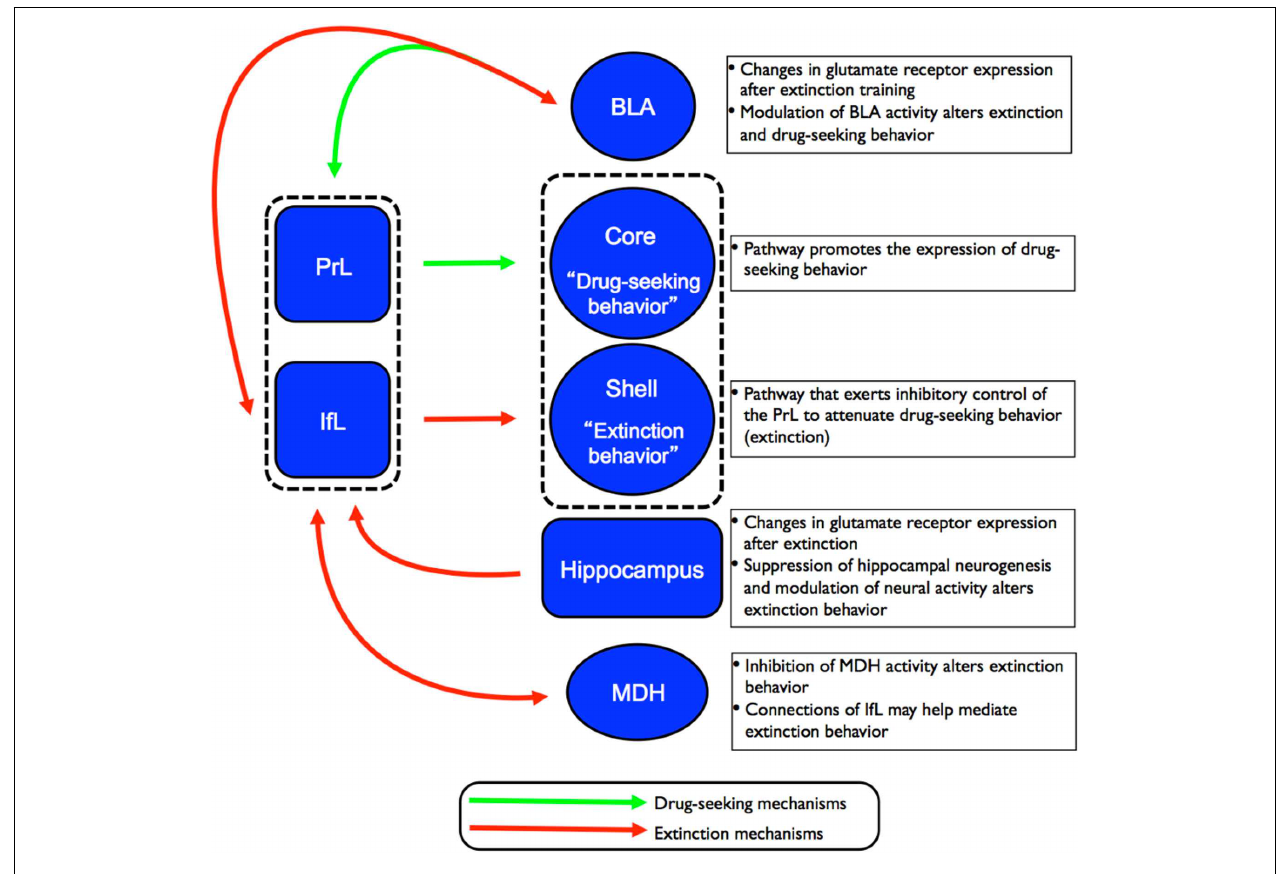
regulates the expression of extinction behavior (indicated by red arrows). Recent studies have also implicated the involvement of other brain regions such as the hippocampus, MDH, and BLA in the neurocircuitry of extinction of drug-seeking